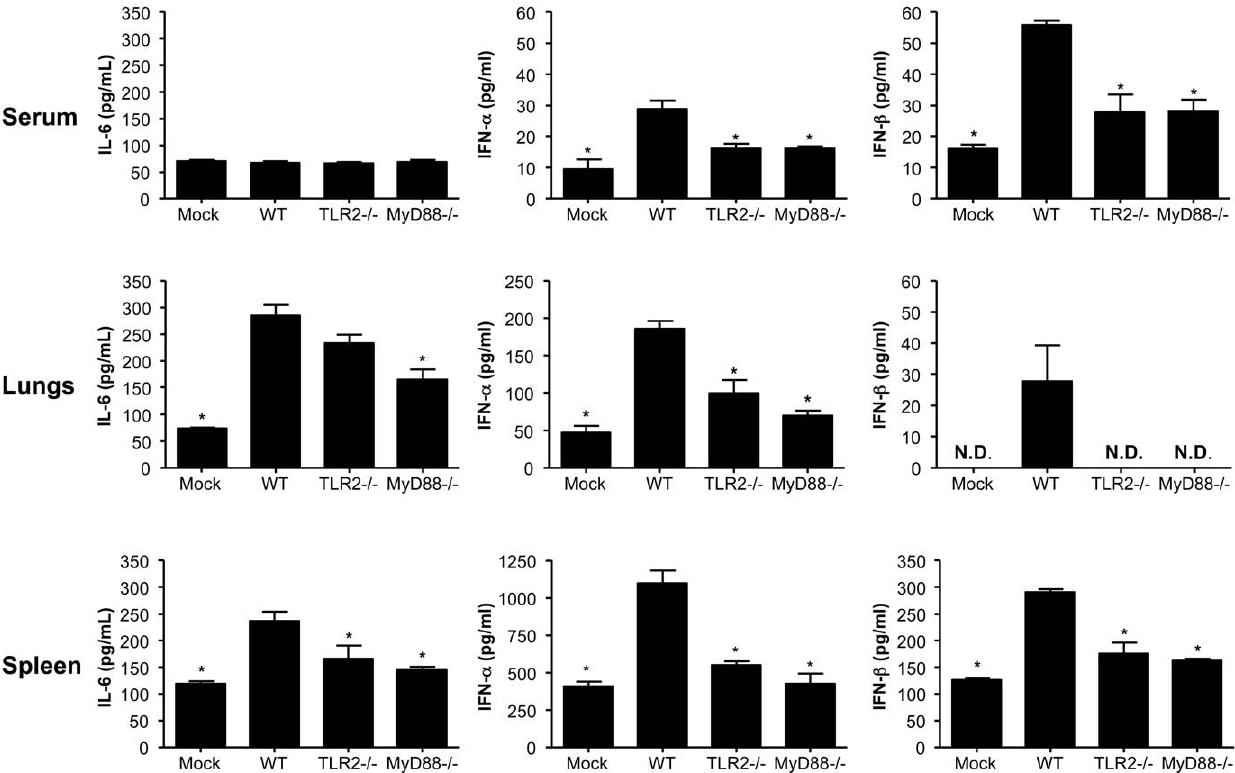
Figure 6. Cytokine production in sera, lungs and spleens of mice upon MHV-68 treatment. WT, TLR2 2 / 2 and MyD88 2 / 2 mice were injected iv. with mock control or UV-irradiated MHV-68 particles and sacrificed at 10 or 24 hours post-treatment. Concentration levels of IL-6 and IFN- a were determined by ELISA in sera, lung and spleen homogenates after 24 hours. IFN- b levels were tested at 10 hours post-treatment. Data are representative of two different experiments. Values significantly different ( p , 0.05) from WT mice are indicated by (*). N.D.: not detected.